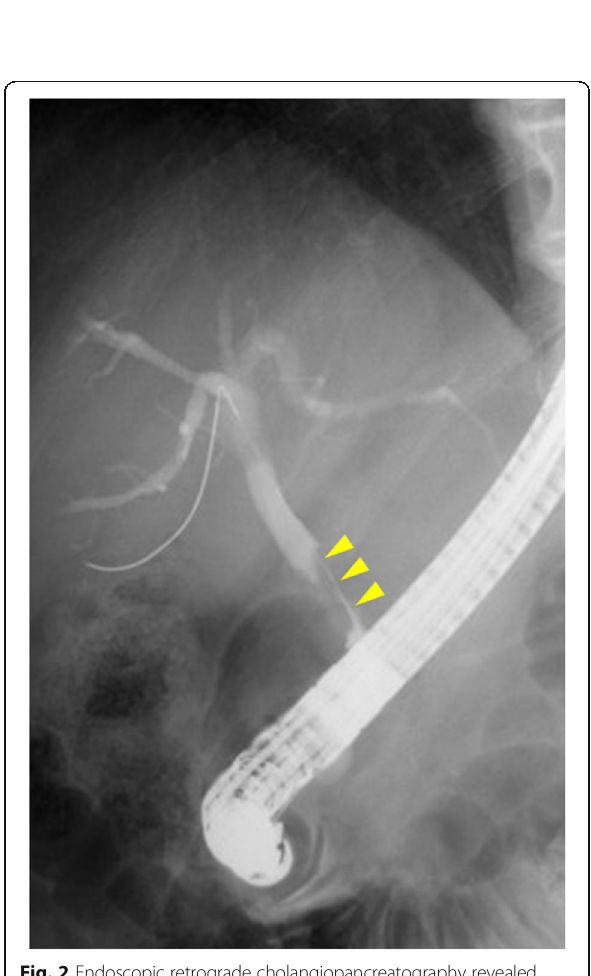
Fig. 2 Endoscopic retrograde cholangiopancreatography revealed mild dilatation of the intra- and extrahepatic bile duct and an irregular filling defect in the middle portion of the common bile duct